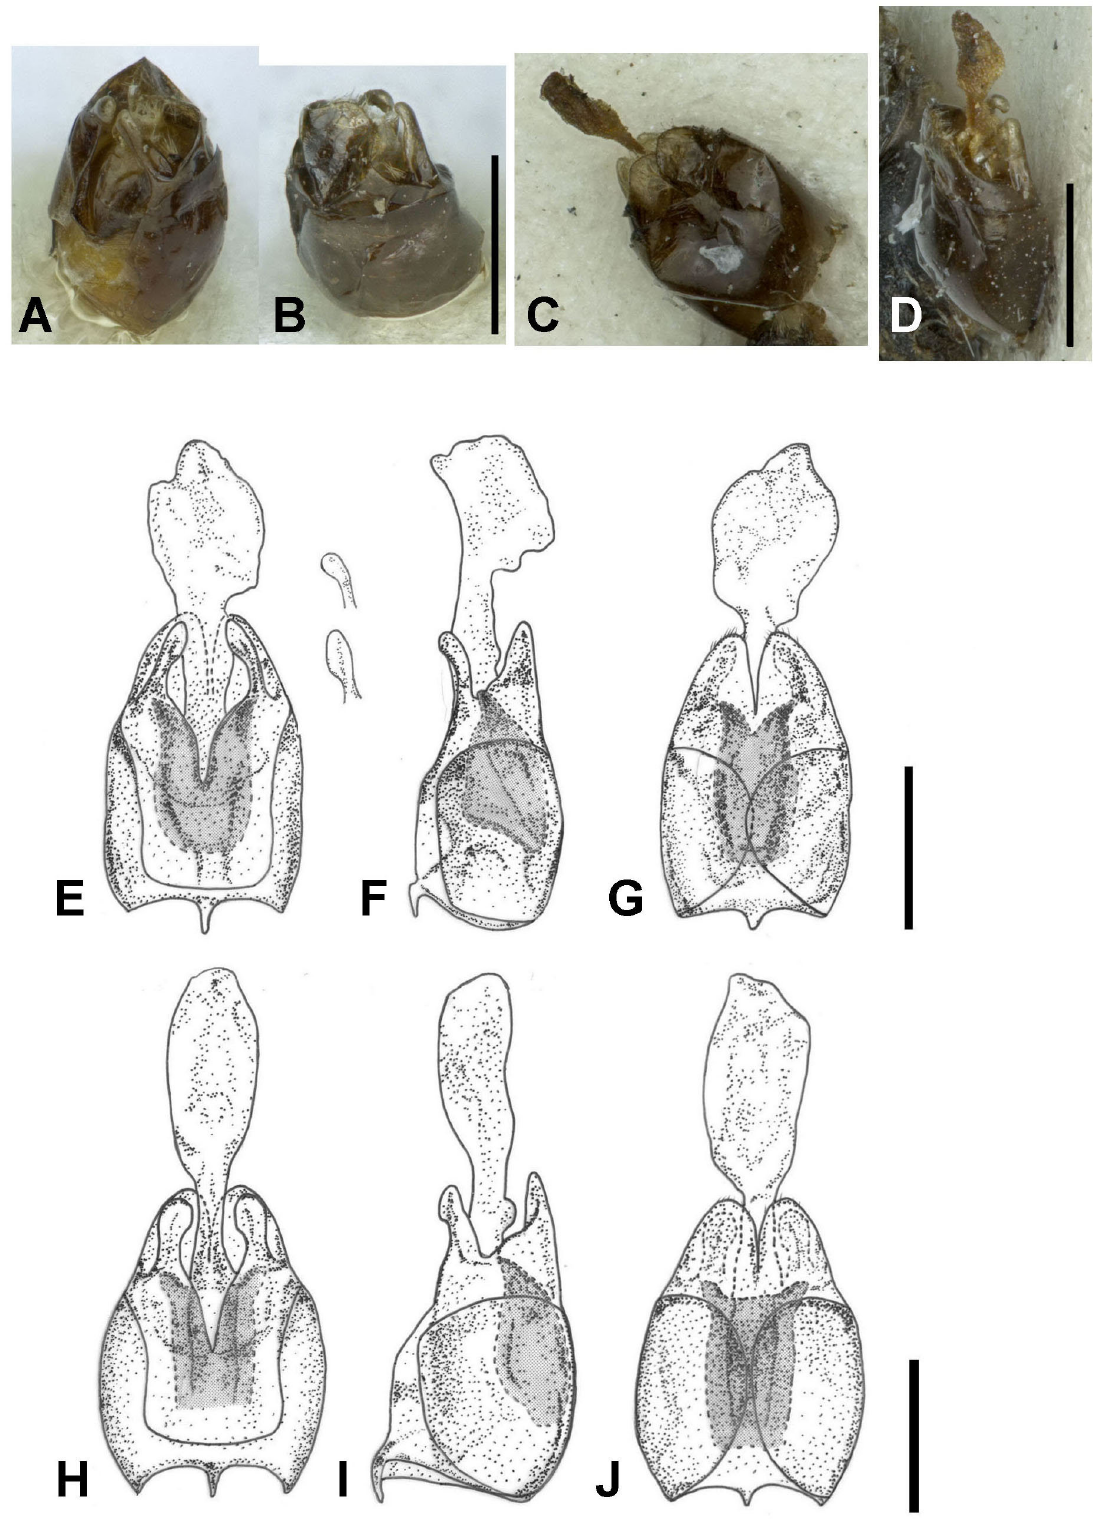
Fig. 4. Aedeagus. A–B . Lycocerus araticollis (Fairmaire, 1897). C–D . L. griseopubens (Pic, 1928). E–G . L. nigripennis (Pic, 1938). H–J . L. aurantiacus Hsiao & Okushima sp. nov. A. Ventrolateral view. B. Dorsolateral view. E, H. Ventral view. D, F, I. Lateral view. C, G, J. Dorsal view. Scale bars: 0.5